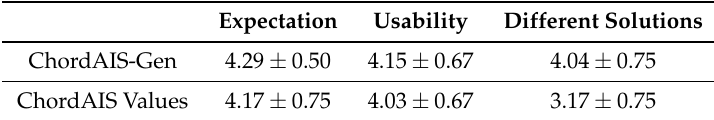
Shows the percentages of satisfaction when the users finished testing the ChordAIS-Gen